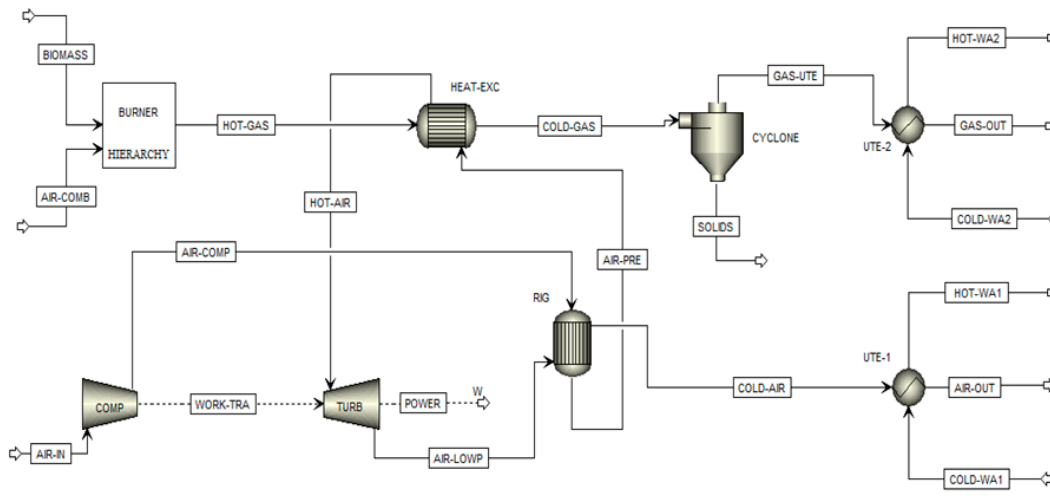
Figure 11. The main flowsheet of the model developed by Aspen Plus.